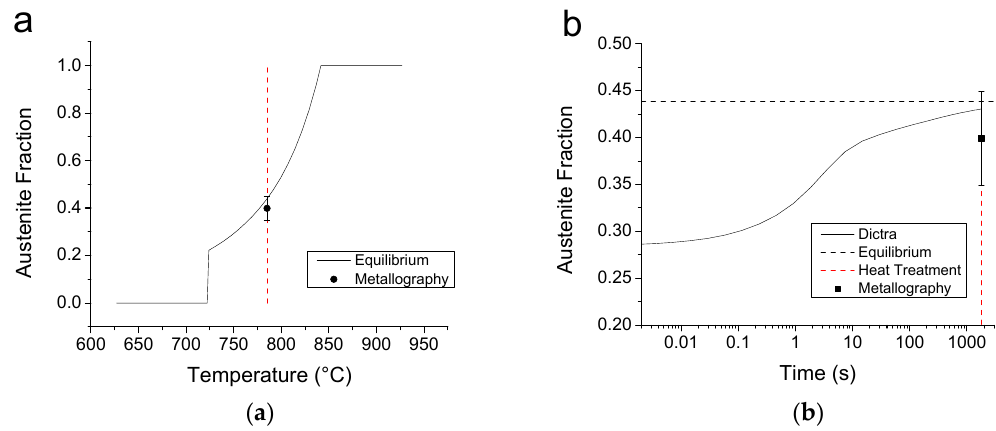
Figure 1. ( a ) Temperature dependence of the equilibrium fraction of austenite formed on heating and ( b ) calculation of the time dependence of the austenite formation at 785 °C.